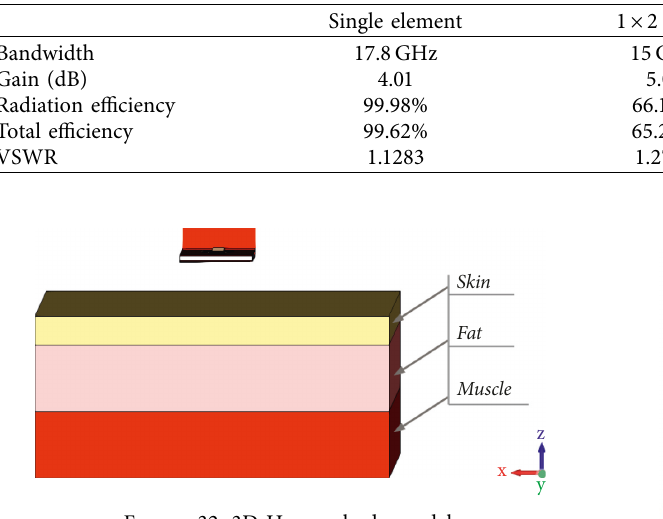
Figure 32: 3D Human body model.